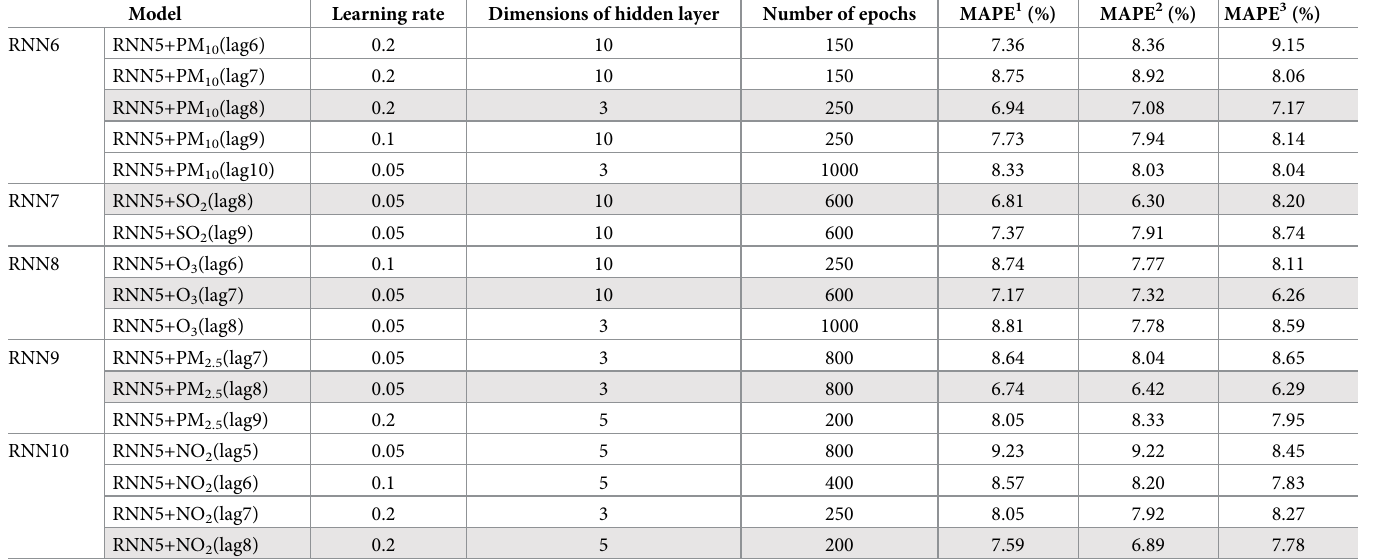
Table 8. Training results of RNN models with incorporating air pollutants (O 3 , PM 2.5 , PM 10 , SO 2 , and NO 2 ). Model